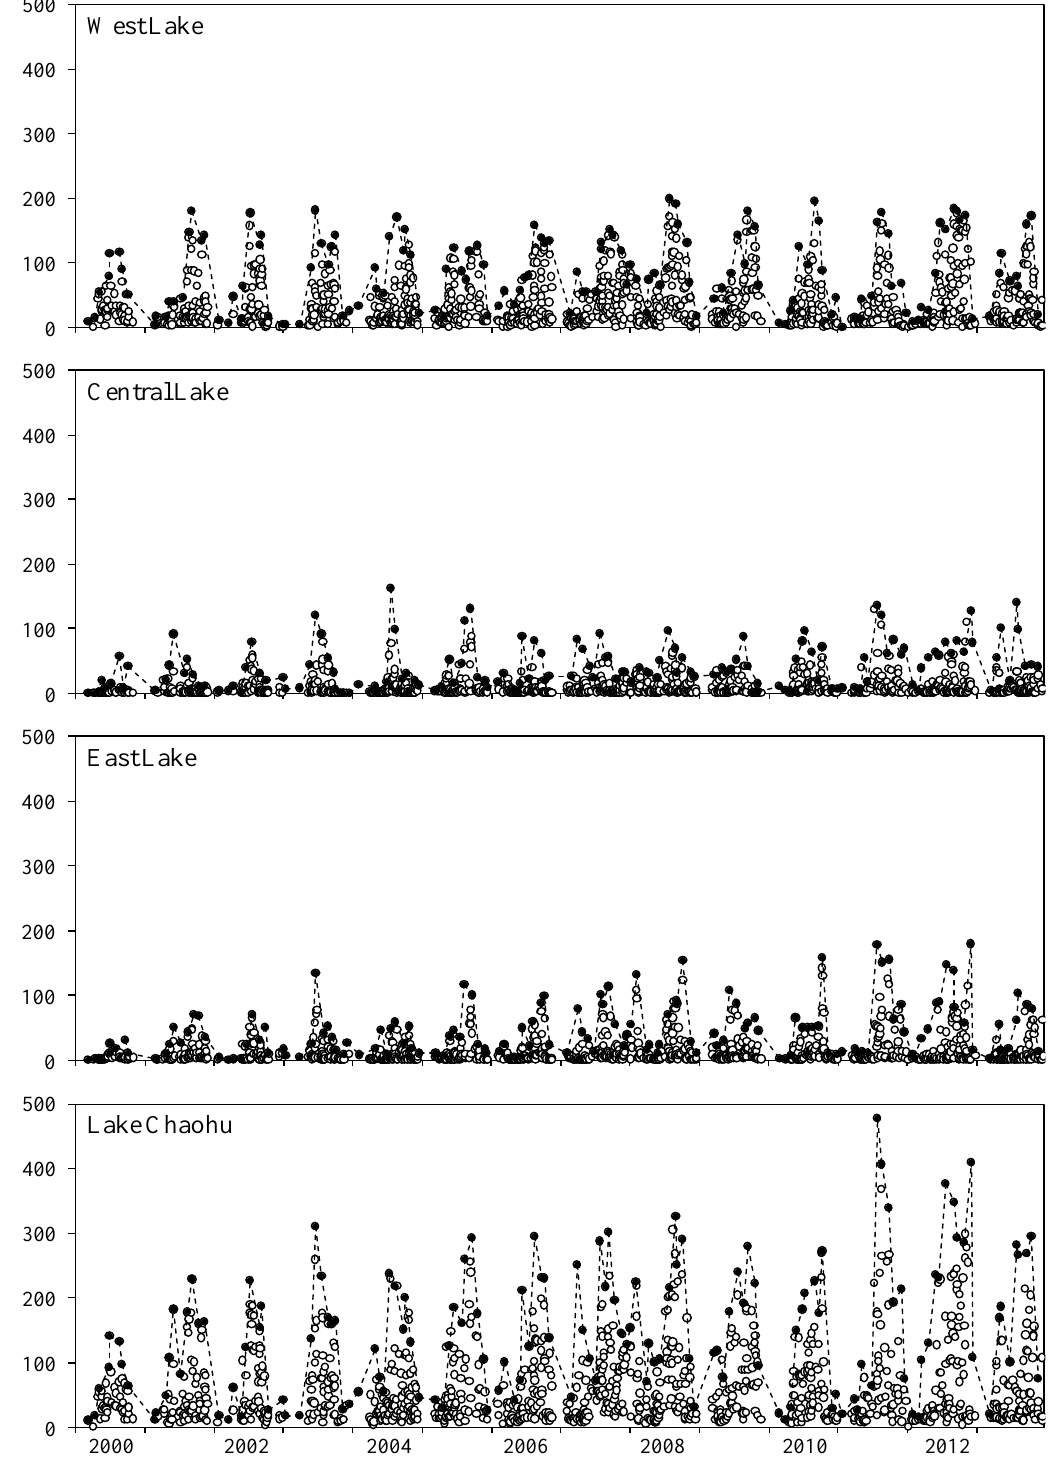
Figure 2. Daily area coverage of floating algae blooms for each lake segment and for the whole of Lake Chaohu. The solid circles represent the monthly maxima in floating algae